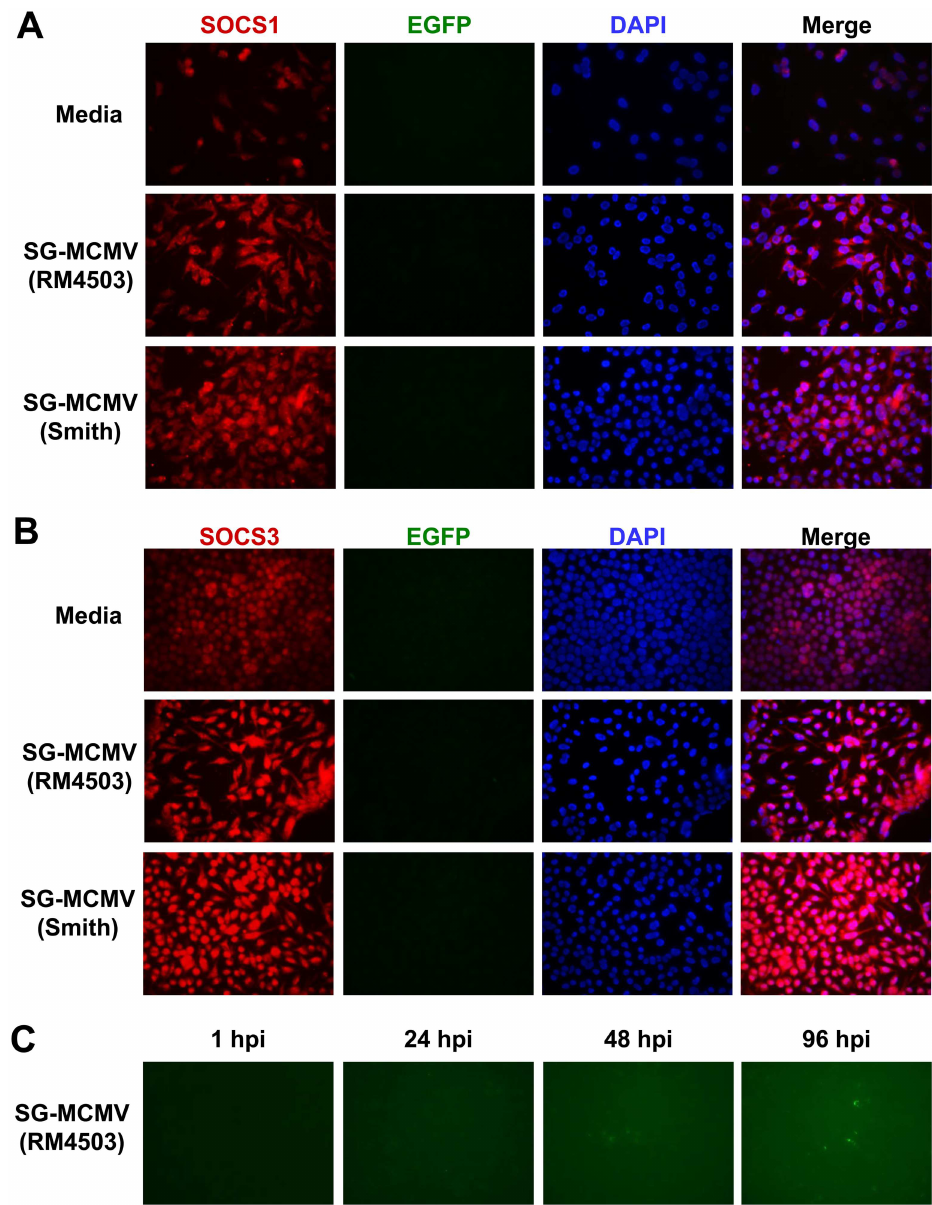
Fig 8. Infection of IC-21 mouse macrophages with EGFP-expressing SG-MCMV RM4503 stimulates SOCS1 and SOCS3 proteins, despite lack of detection of EGFP. IC-21 cells were treated with media or infected (MOI = 3 PFU/cell) with wild type SG-MCMV (Smith) or SG-MCMV mutant RM4503, which expressesEGFP under the control of the IE2 promoter. At 3 hpi, cells were methanol-fixed and stainedwith antibodies detectingSOCS1 (A) or SOCS3 (B) (red). SOCS1 and SOCS3 expressionwas increased,despite lack of detectionof MCMV IE2-driven EGFP (green)in these cells at 3 hpi. Original magnification 400 × . (C) In live IC-21 macrophages infected with SG-MCMV mutant RM4503, IE2 promoter-driven EGFP was not visibly detected until 48 hpi and increasedthereafter. Originalmagnification 200 ×